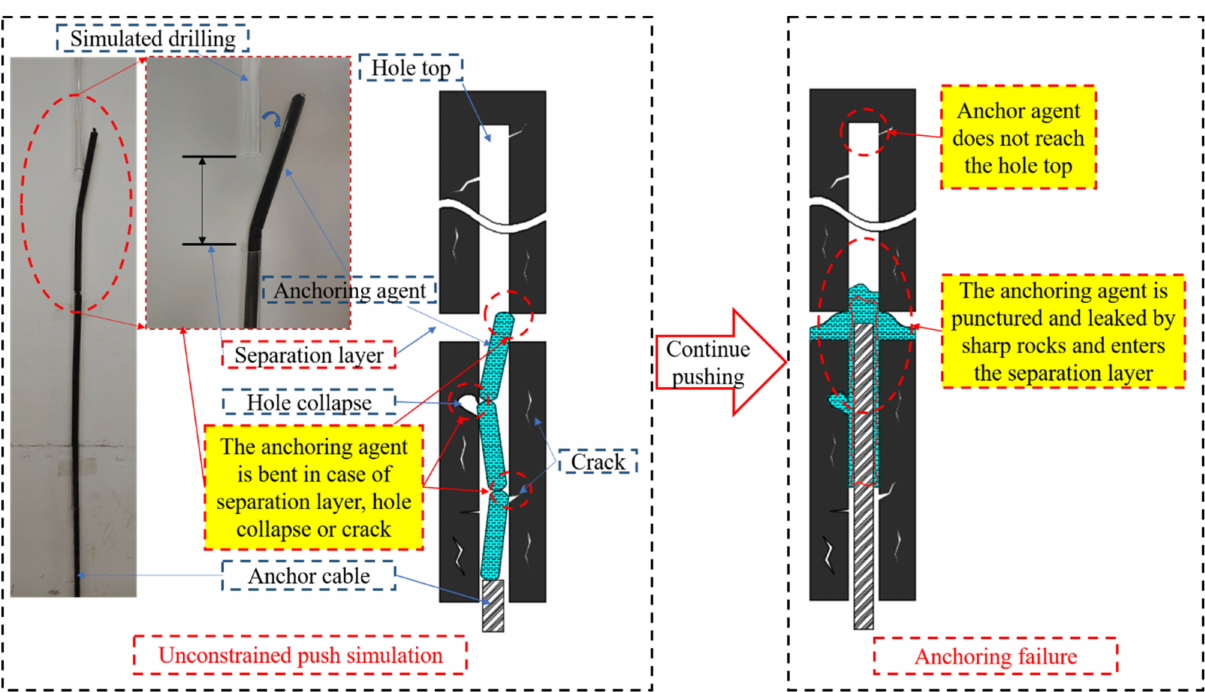
Figure 9. Disadvantages of unrestrained integral pushing anchoring